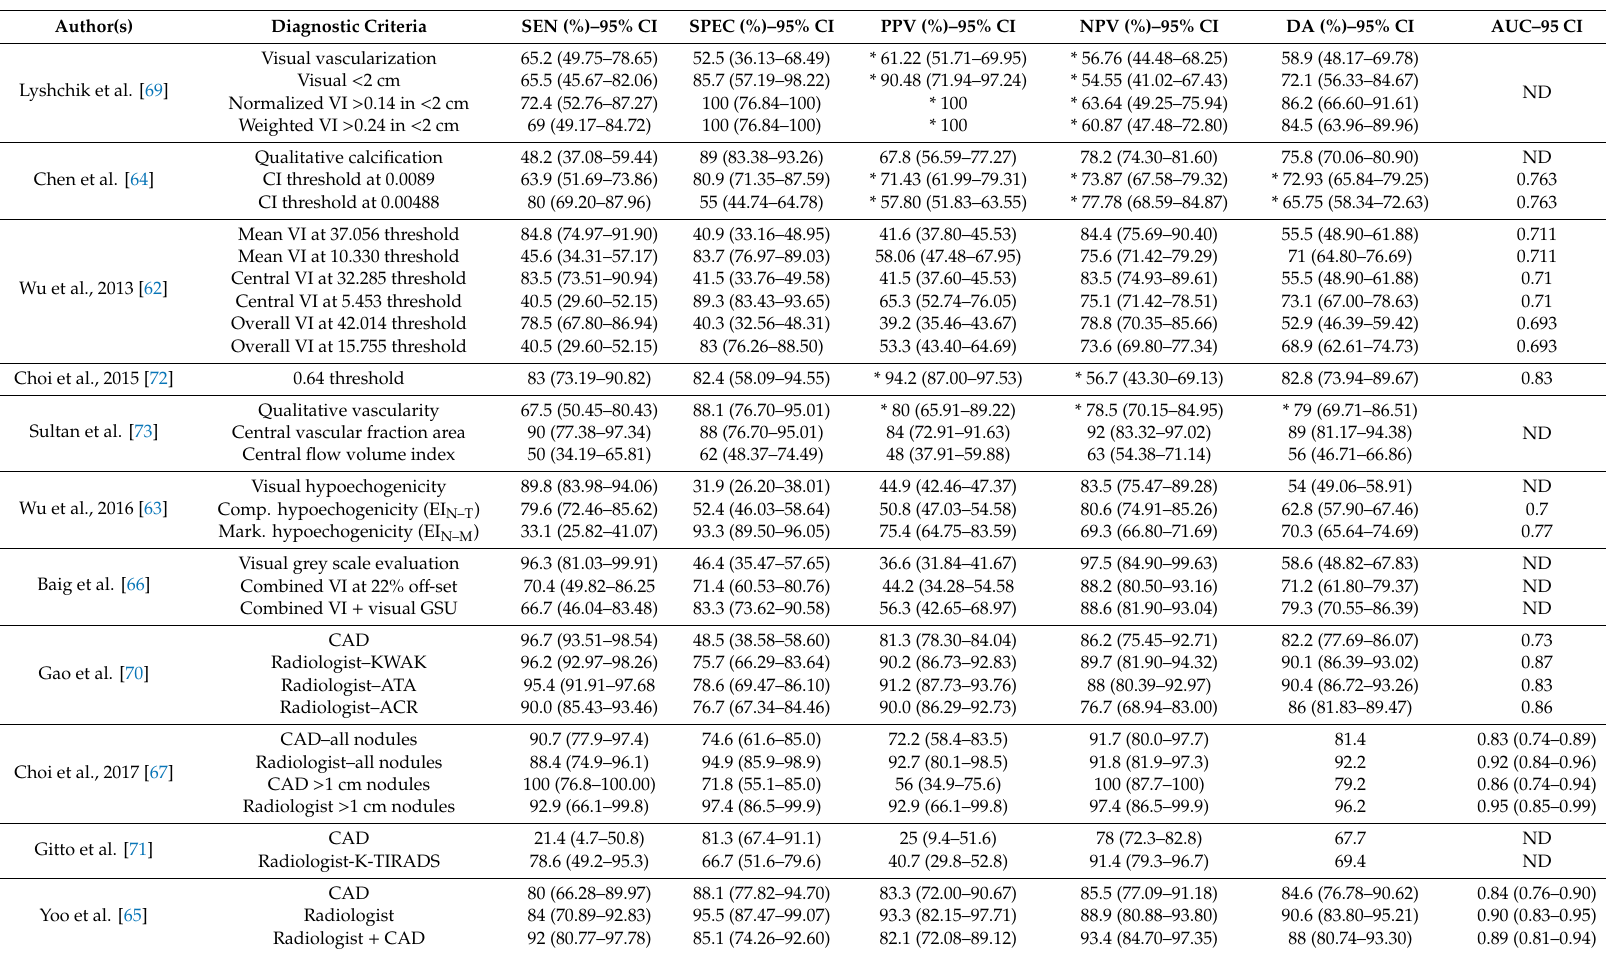
Table 3. Diagnostic performance of thyroid ultrasound computer-aided diagnosis (CAD) for characterization of malignant and benign thyroid